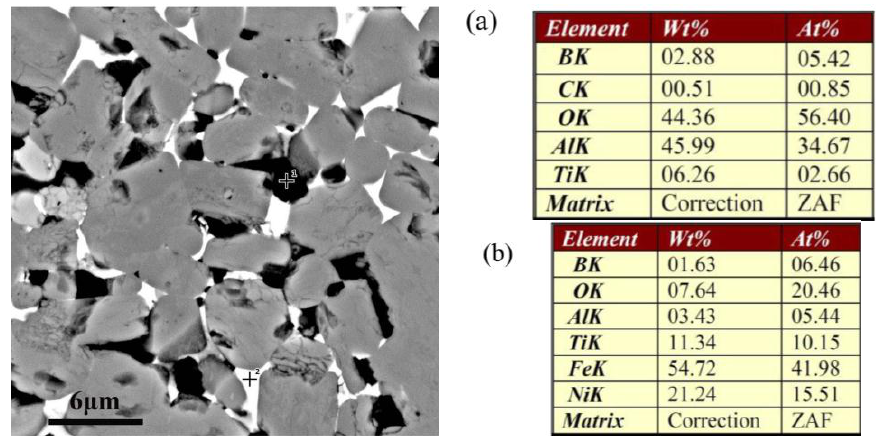
Figure 7. EDS (energy dispersion spectrum) analysis corresponding to the black